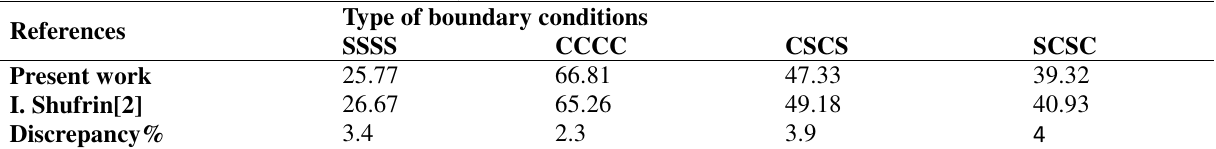
Non-dimensional buckling load ( ), for [30 -30 30] plates of different boundary conditions, (